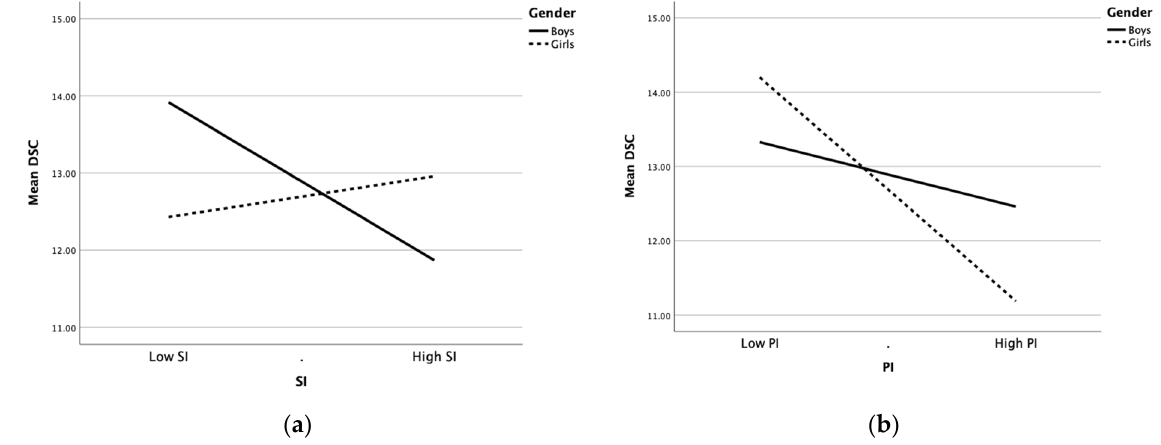
Figure 3. Moderating effect of gender in the relationship between ( a ) social impact (SI) on dental self-confidence (DSC) and ( b ) psychological impact (PI) on DSC.